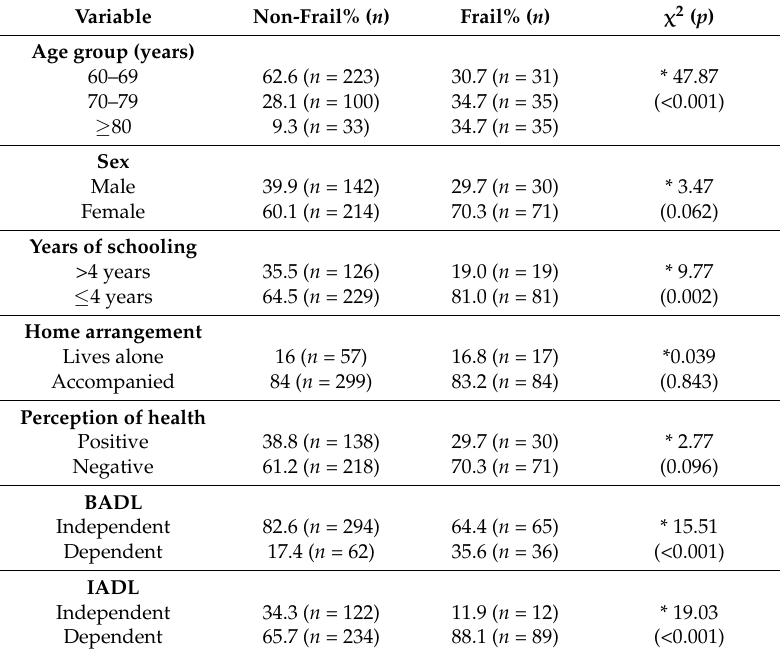
Table 1. Participants characteristics according to frailty